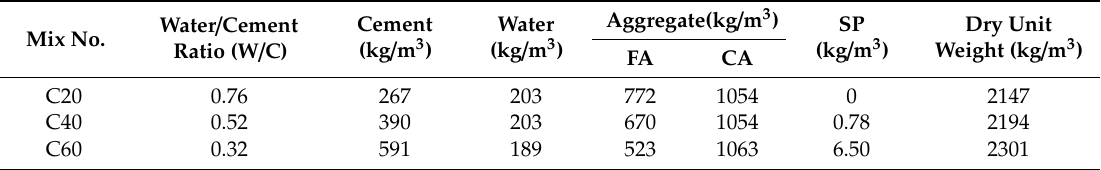
Table 4. Concrete mix design composition.